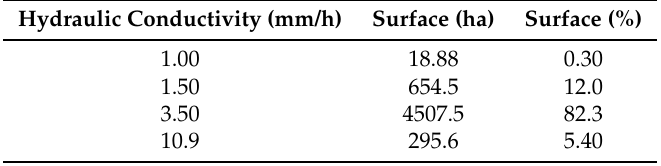
Table 5. Distribution of estimated hydraulic conductivity above the study